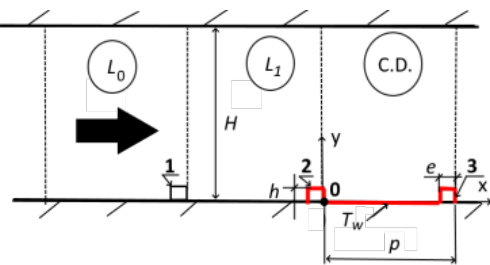
Figure 1. Scheme of flow in a two-phase turbulent flow in a ribbed flat duct (not to scale). Ab- breviations L 0 and L 1 are the computational domains for the preliminary simulations; C.D. is the computational domain; and 1, 2, and 3 are the 1st, 2nd, and 3rd